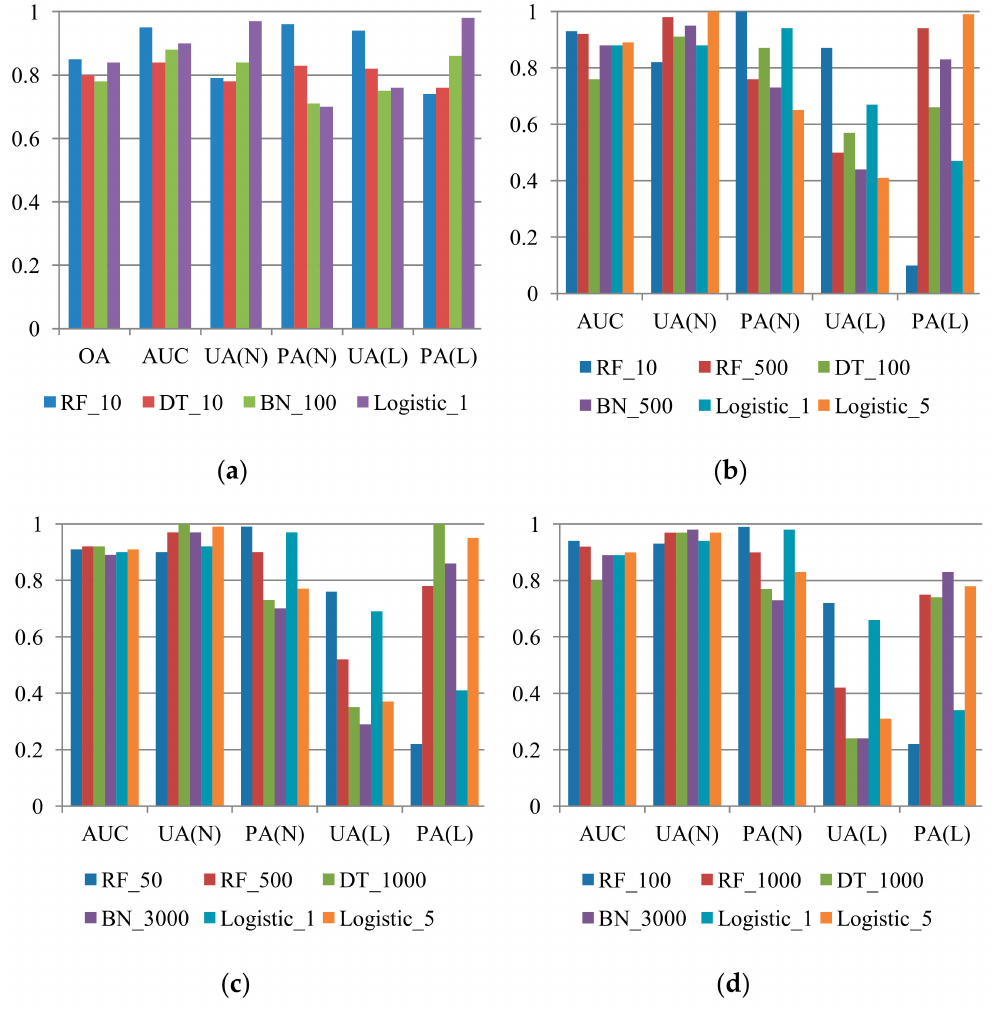
Figure 7. Comparison of the representative results ( Y axis: accuracies) of Typhoon Fung-wong prediction using RF, DT, BN, and logistic algorithm with cost-sensitive analysis, where RF, DT, BN, OA, UA, PA, AUC, L, and N indicate random forests, decision tree, and Bayes network algorithm, overall accuracy, user’s accuracy, producer’s accuracy, area under ROC curve, landslide class, and non-landslide class, respectively. ( a ) L:N = 1:1; ( b ) L:N = 1:4; ( c ) L:N = 1:7; ( d ) L:N =